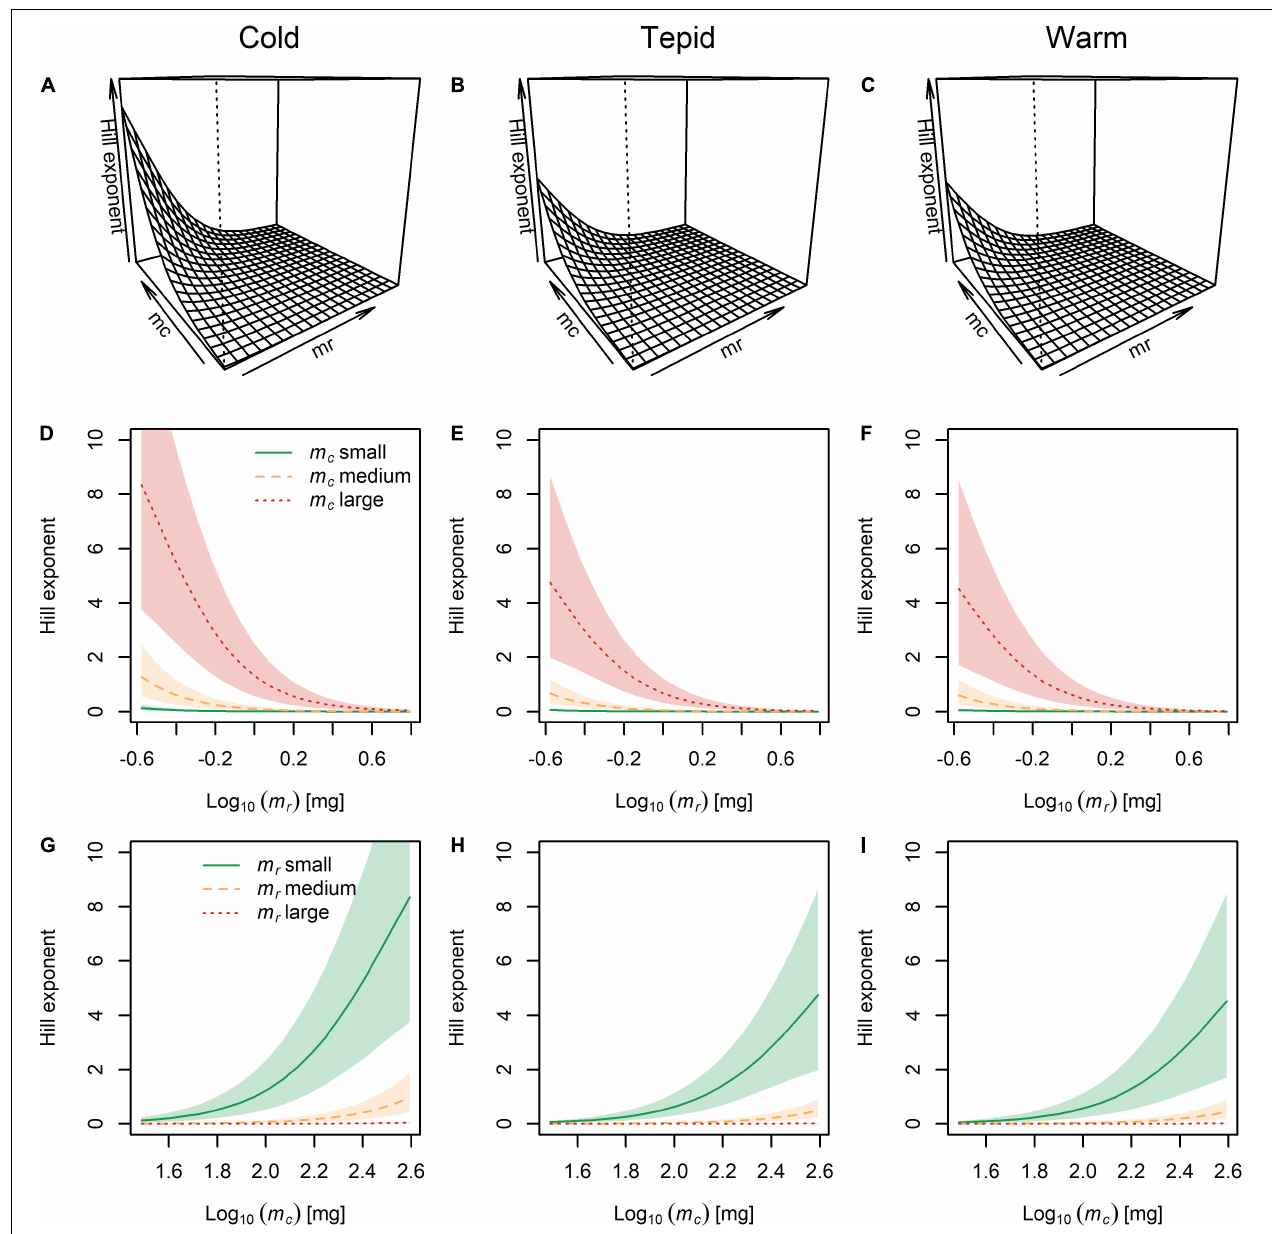
FIGURE 5 | The combined effects of temperature and body mass of the predator ( m c ) and prey ( m r ) on the Hill exponent. (A–C) Three-dimensional visualization of Hill exponents across the full range of predator and prey body masses at each experimental temperature. (D–F) Hill exponents for small, medium, and large predators across the full range of prey body masses at each temperature. (G–I) Hill exponents for small, medium, and large prey across the full range of predator body masses at each temperature. Lines represent the model fit and shaded areas are the Bayesian 95% posterior probability